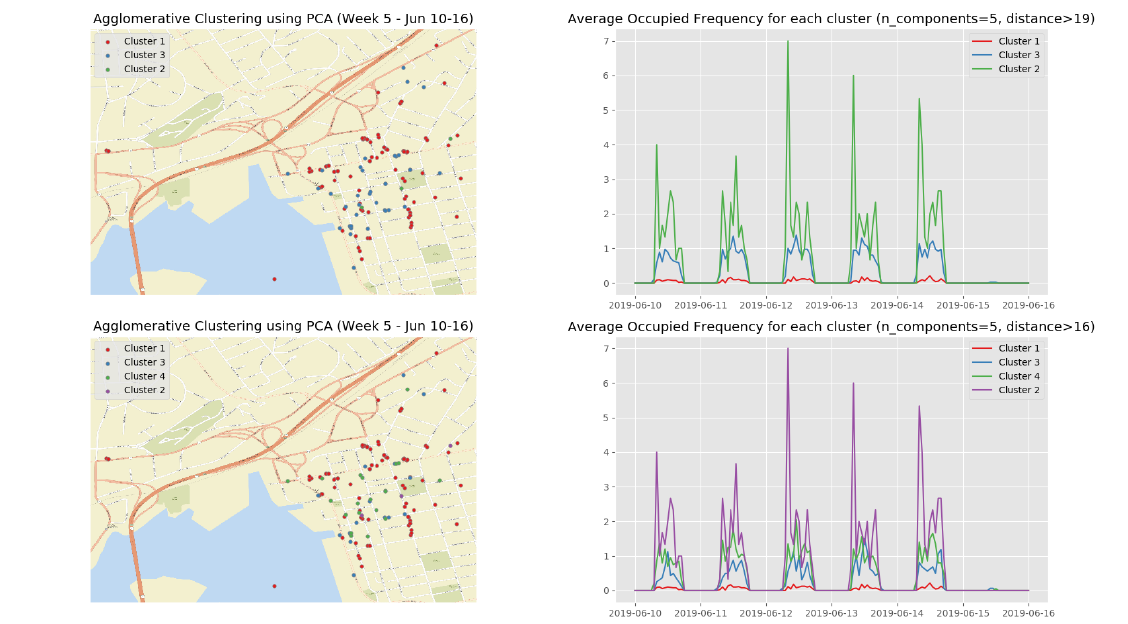
Figure A10. Clustering results using PCA for the 5th